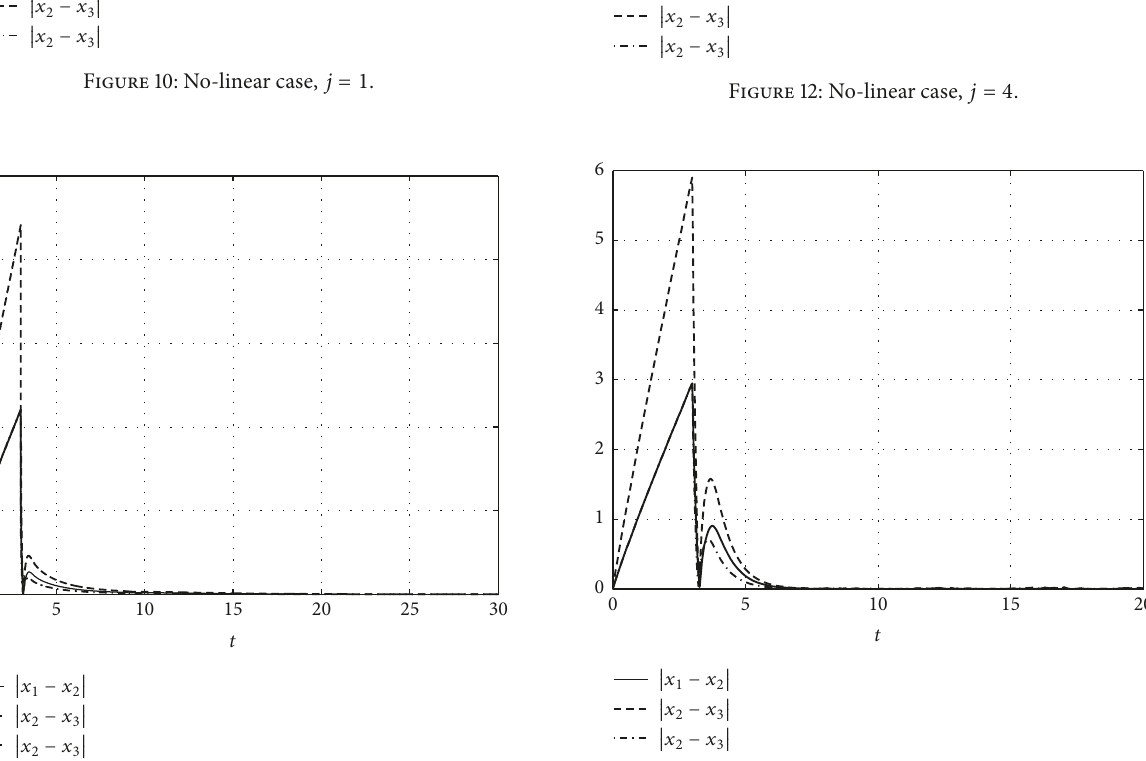
Figure 11: No-linear case, 𝑗 = 2 .